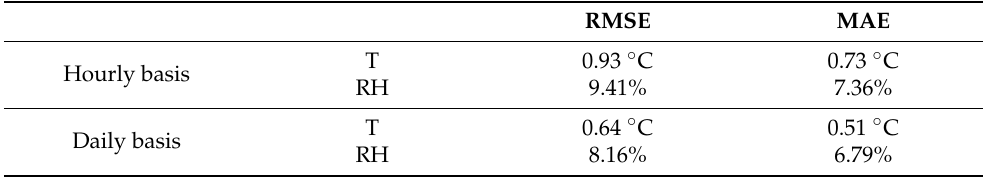
Table 9. Statistical indices for evaluating the goodness-of-fit of the model in terms of the tempera- ture (T) and relative humidity